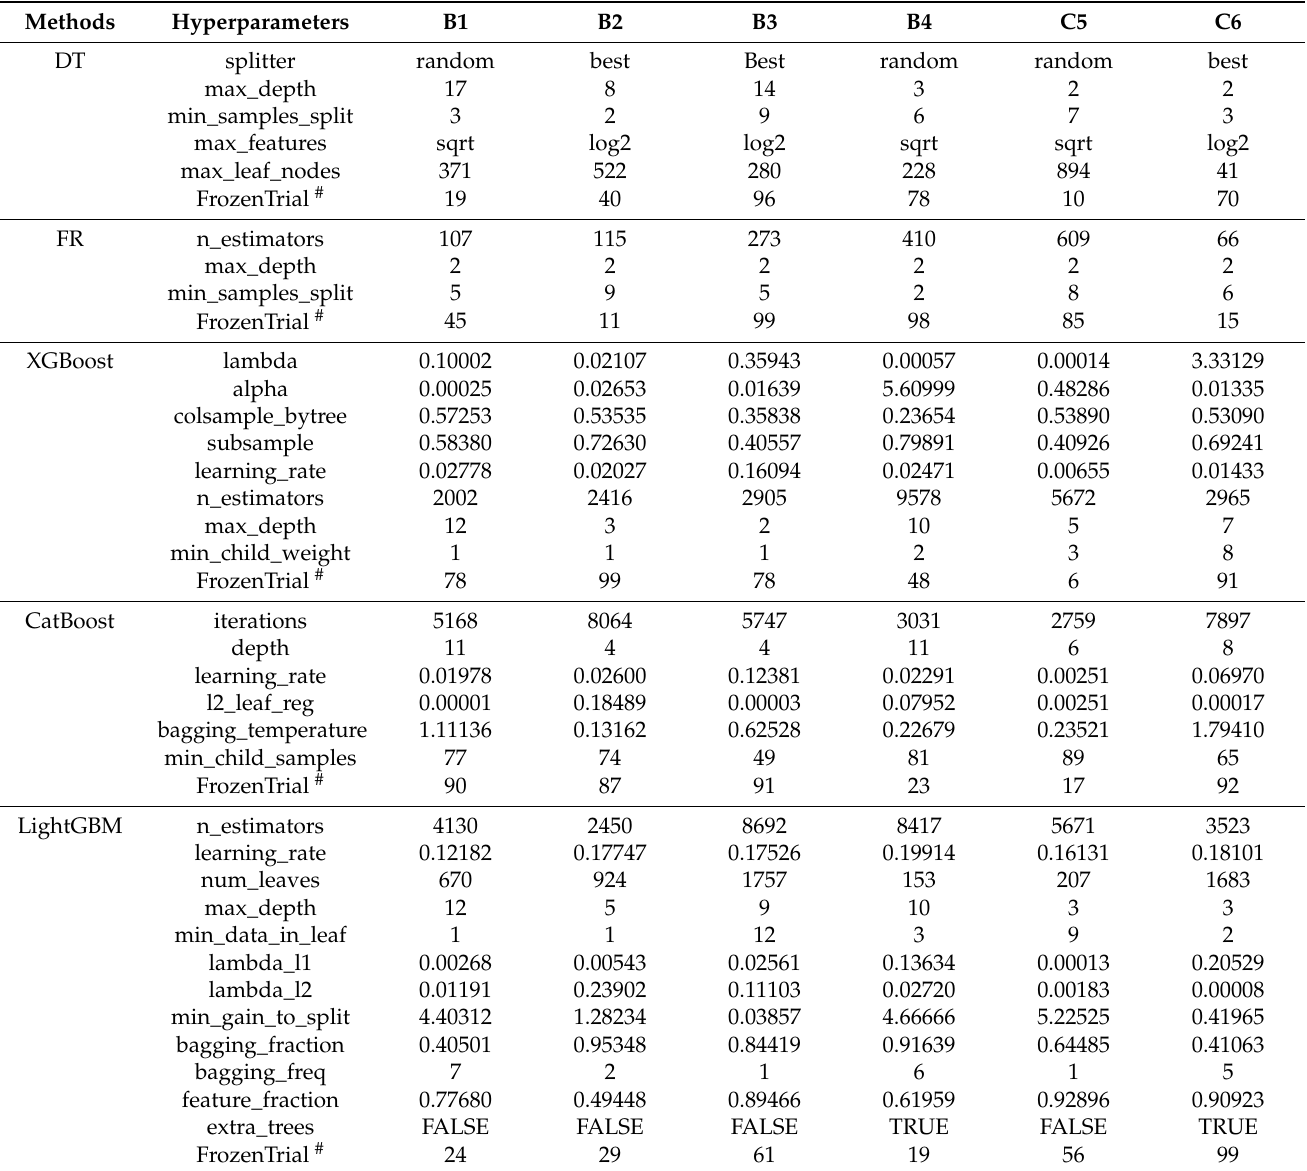
Table 10. The hyperparameters for category B and C models provided by